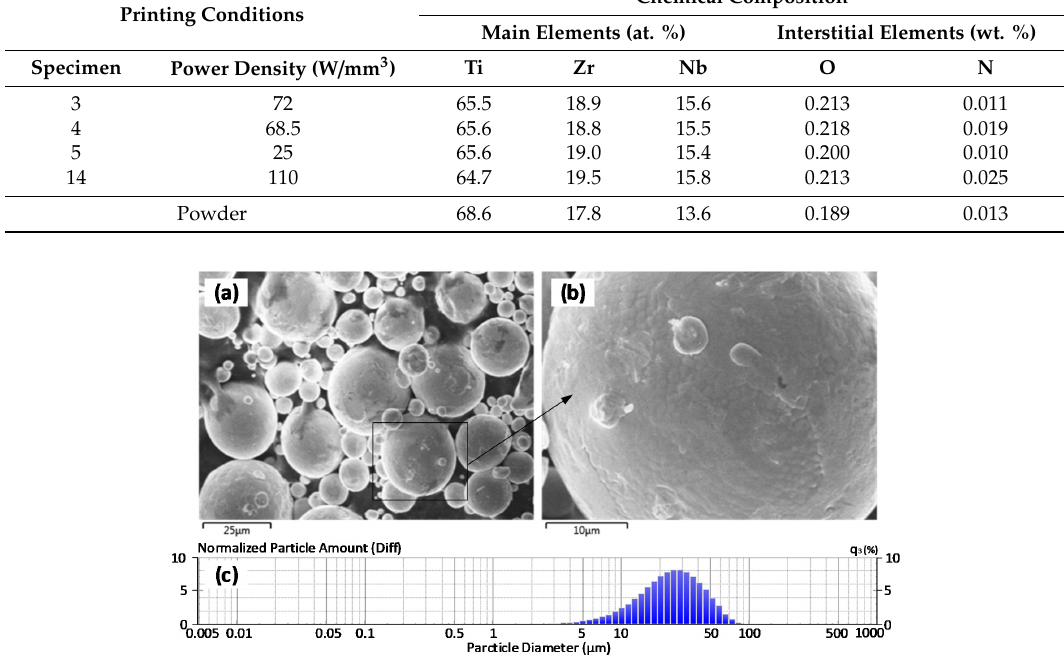
Figure 3. SEM images of gas-atomized Ti-18Zr-14Nb alloy powder: ( a , b ) morphology and microstructure of powder particles; ( c ) particle size distribution (PSD) of the Ti-18Zr-14Nb powder. Table 3. Chemical compositions of the Ti-Zr-Nb powder and selected printed specimens.